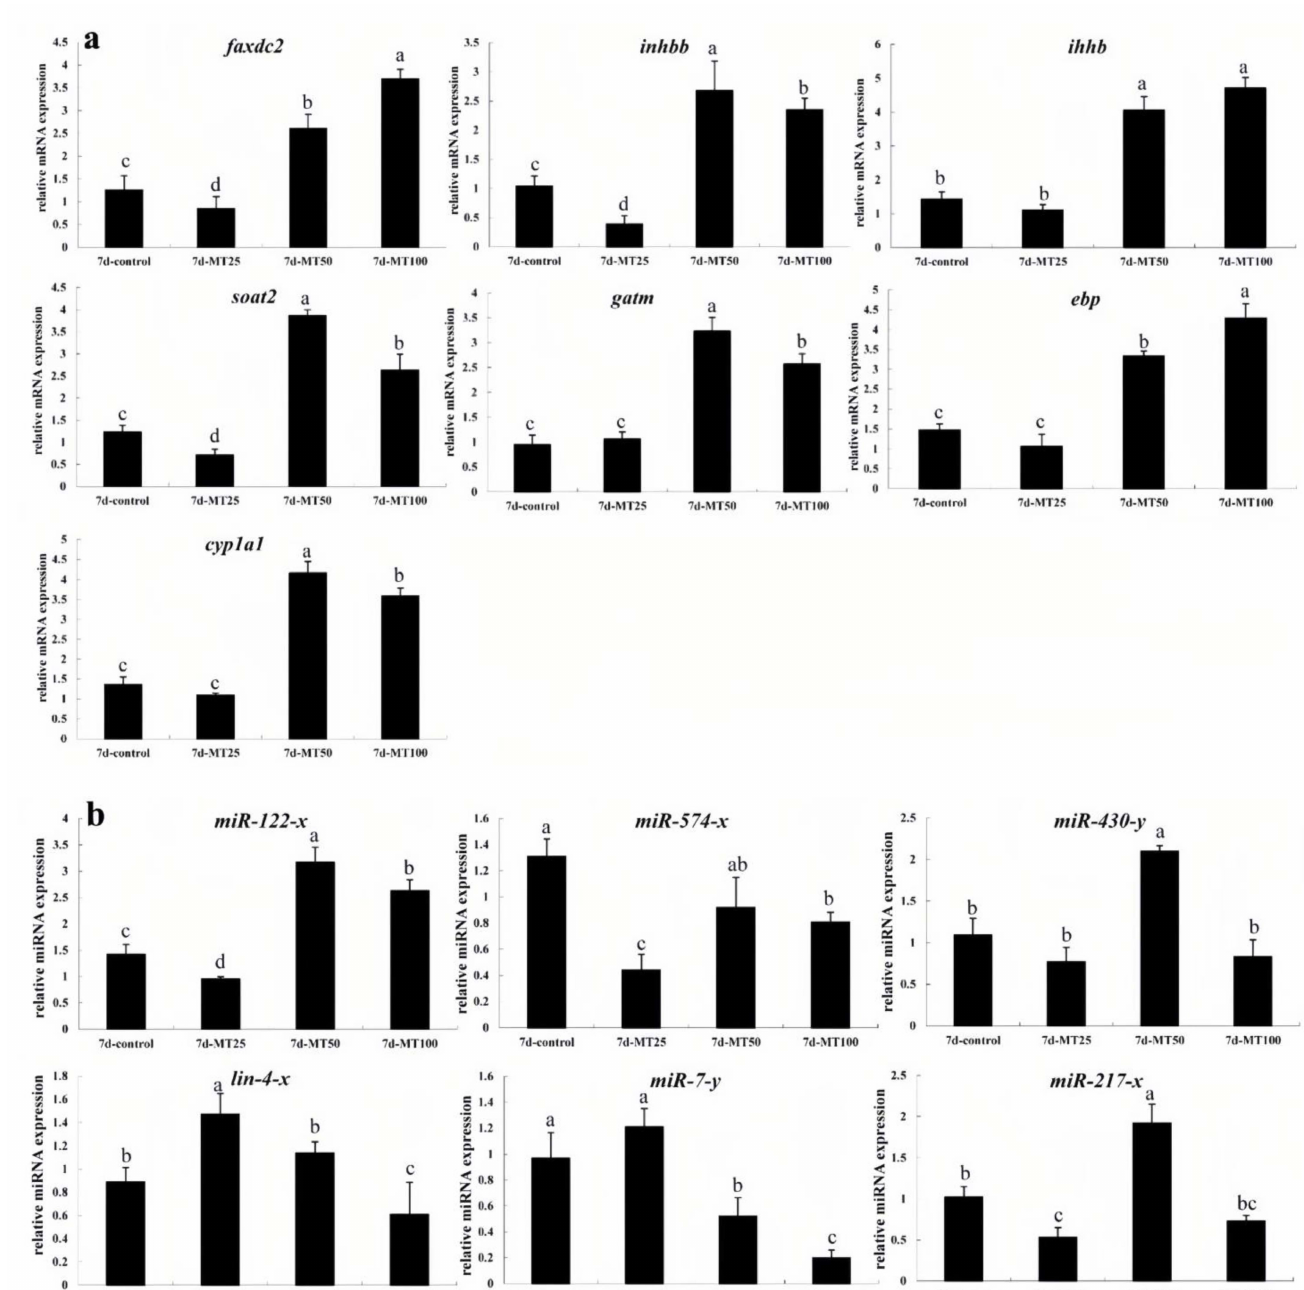
Figure 5. qRT-PCR verifications ( n = 3): ( a ) testicular RNA, ( b ) testicular miRNA expression. The gene names and potential functions are as follows: soat2 (sterol O-acyltransferase 2-like isoform X1, steroid biosynthesis and lipid metabolism), inhbb (inhibin beta B chain-like, cytokine–cytokine receptor interaction) , ihhb (indian hedgehog B protein-like isoform X1, hedgehog signaling pathway) , gatm (glycine amidinotransferase, arginine and proline metabolism) , faxdc2 (fatty acid hydroxylase domain-containing protein 2, biosynthesis of antibiotics), ebp (3 β hydroxysteroid- ∆ 8,7-isomerase, biosynthesis of secondary metabolites) and cyp1a1 (cytochrome P450 1a, retinol metabolism).